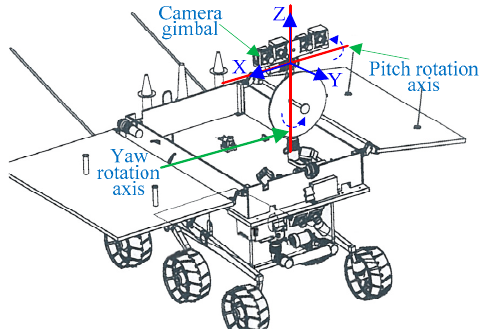
Figure 1. Stereo Vision System of Planetary Rovers.